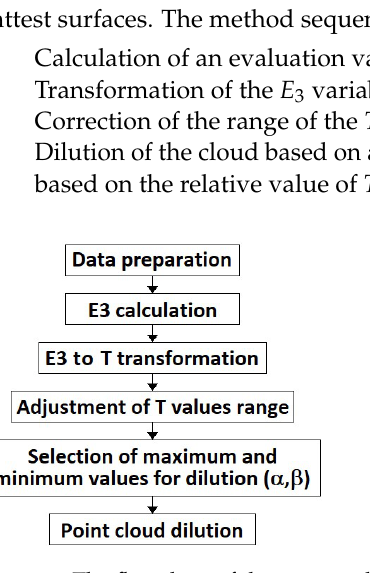
Figure 1. The flowchart of the proposed progressive dilution algorithm.